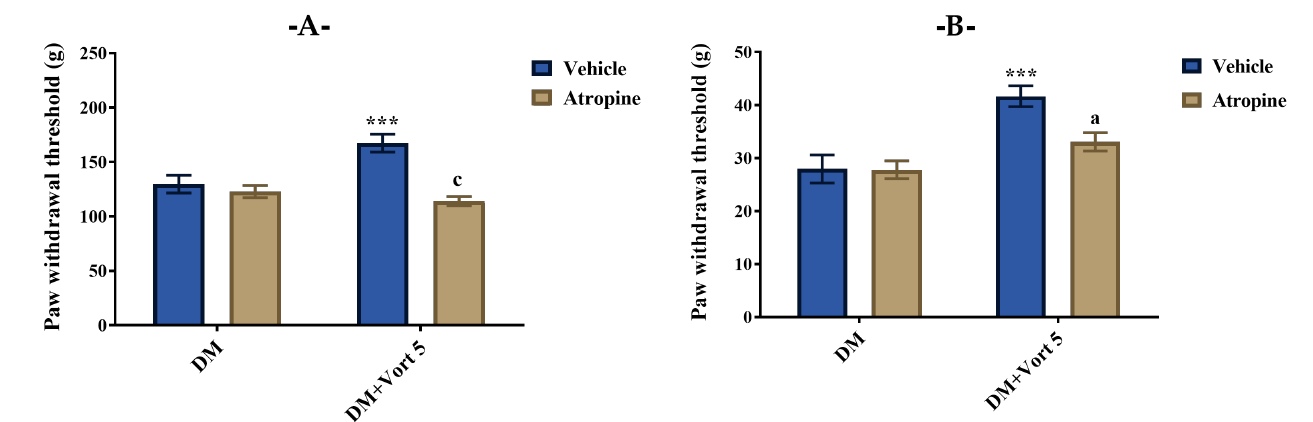
Figure 10. The effects of atropine pre-treatment on antihyperalgesic ( A ) and antiallodynic ( B ) re- sponses induced by the administration of 5 mg/kg vortioxetine in the Randall–Selitto and Dy- namic plantar tests, respectively. Values are given as mean ± S.E.M. Significant difference against vehicle-administered diabetic group (DM) *** p < 0.001; significant difference against vortioxetine- administered diabetic group (DM+Vort 5) a p < 0.05; c p < 0.001. Two-way ANOVA, post hoc Bonferroni multiple comparison test, n = 8.